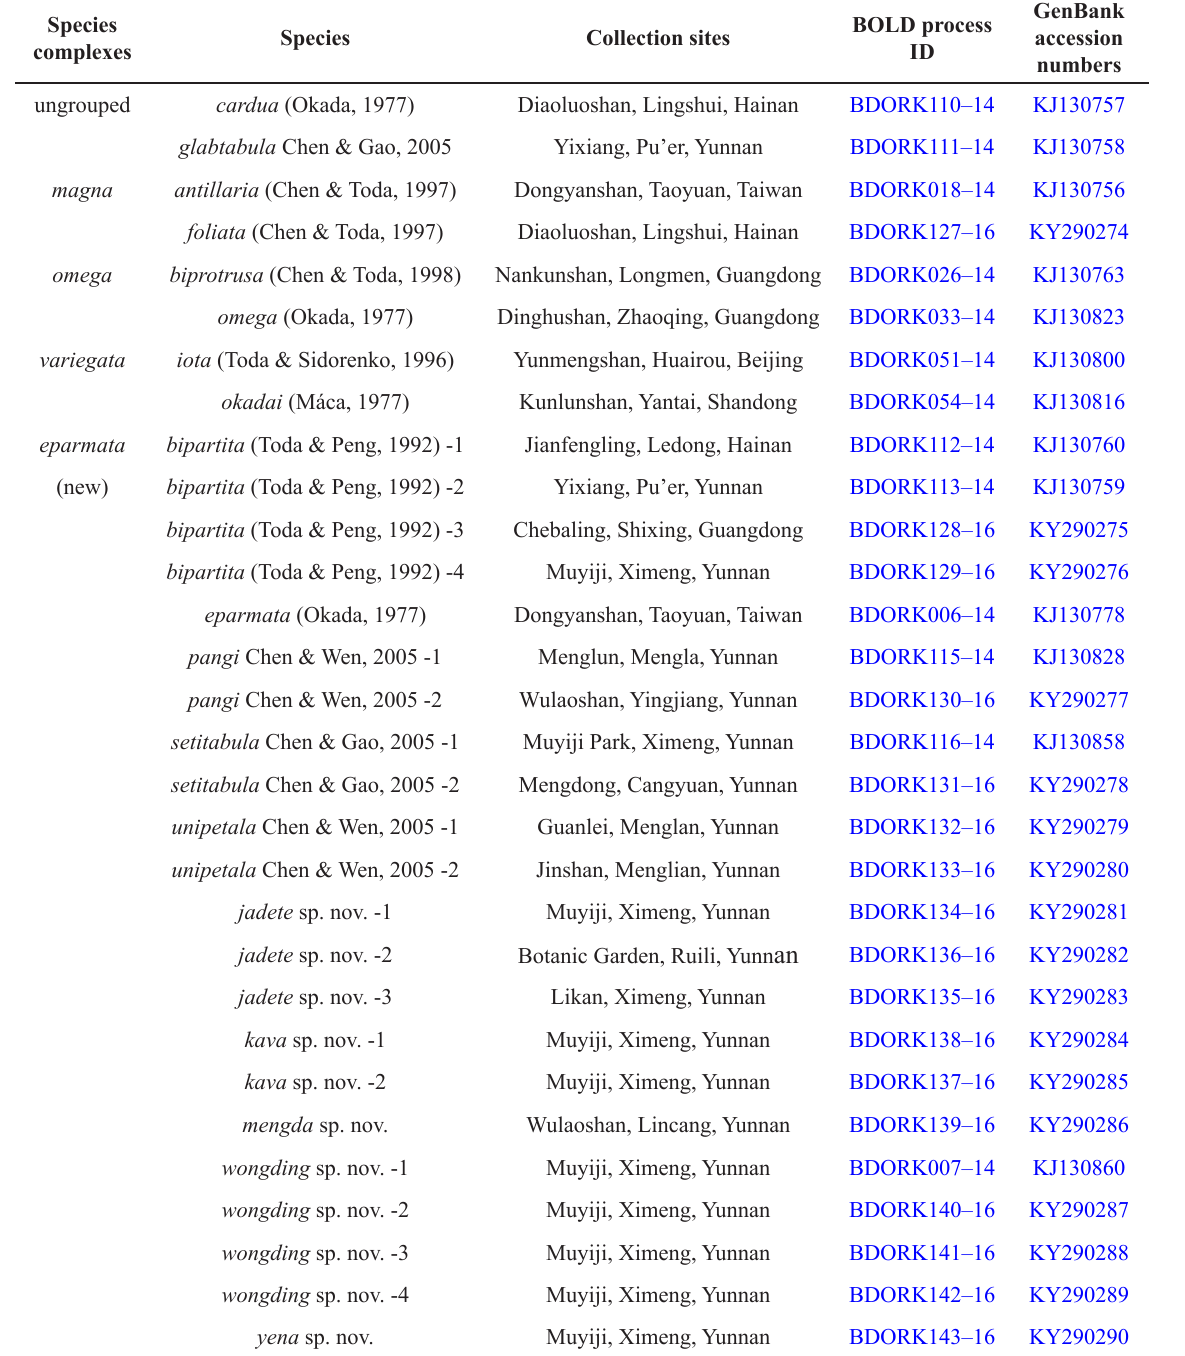
Table 1. Specimens of Phortica used for sampling, including the DNA and accession numbers of the COI